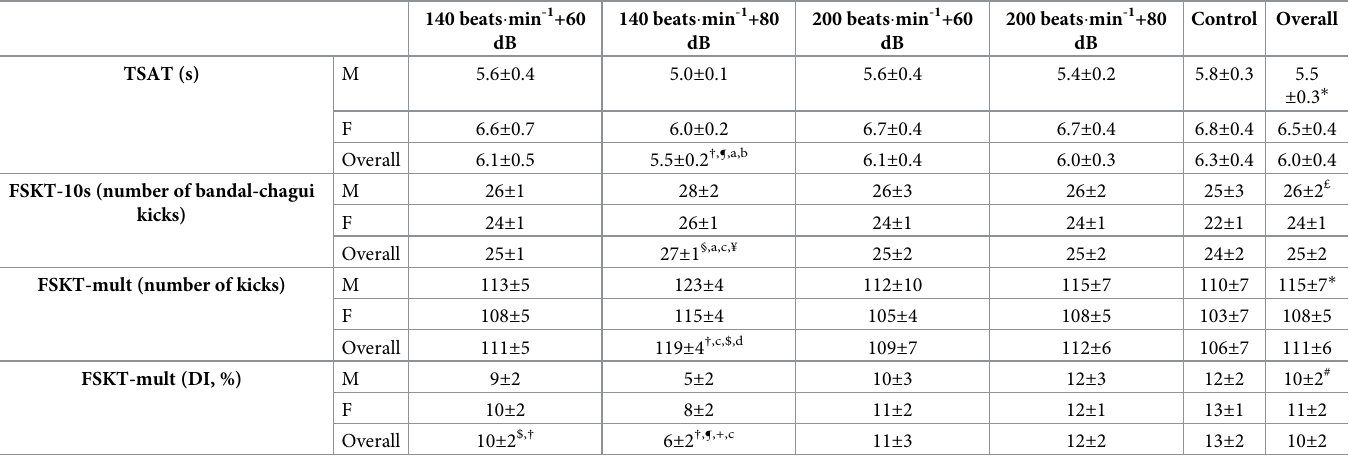
Table 2. Physical performances during the taekwondo-specific tests following the different conditions (values are mean ± SD; n =